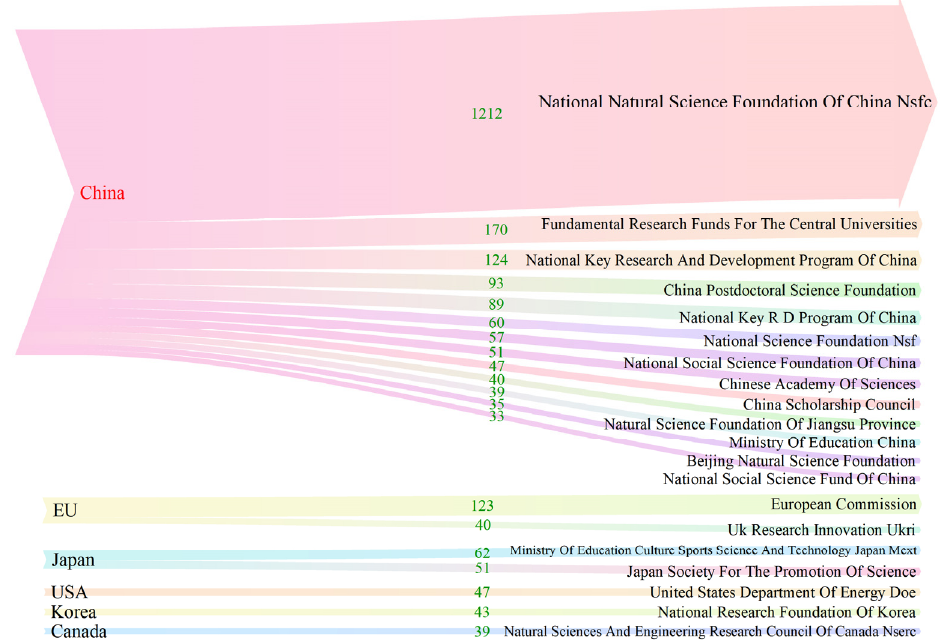
Figure 7. Major funding